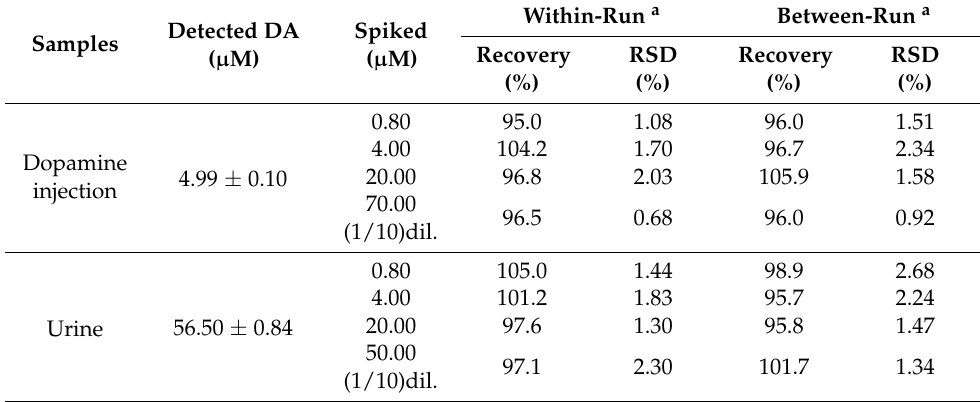
Table 1. Intra- and inter-day accuracy (recovery) and precision (RSD) for the studied dopamine. Samples